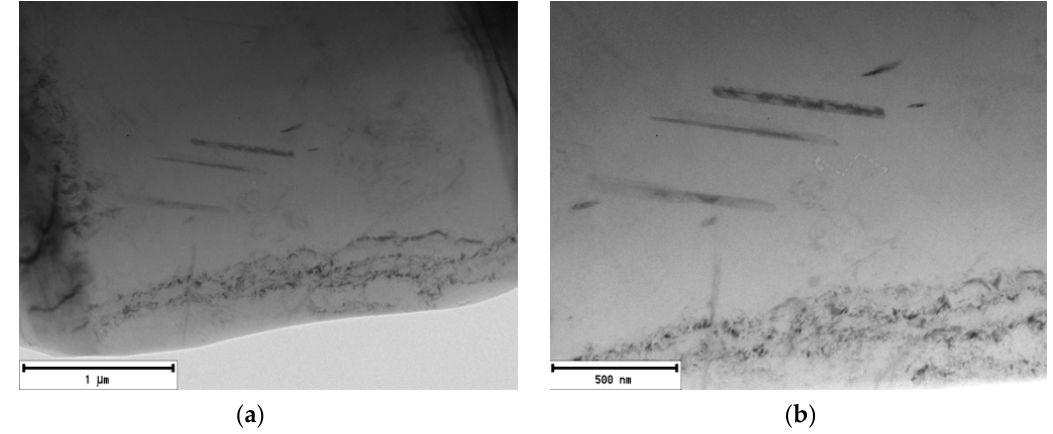
Figure 8. Substructure of 20–80 alloy after natural aging, TEM; ( a ) Overview ( b ) Detailed view.